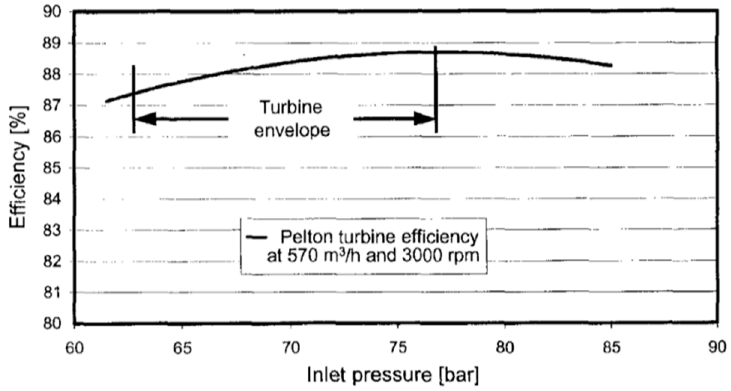
ffi ciency curve